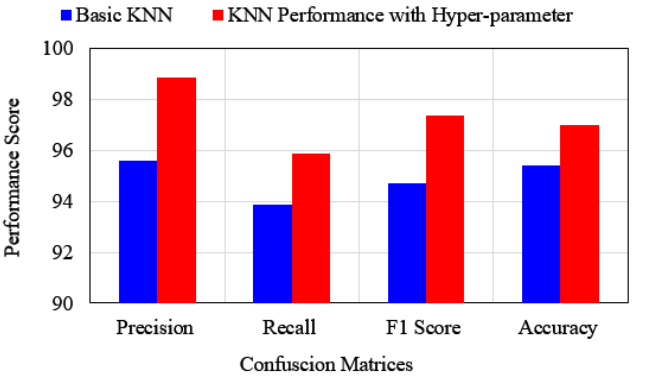
Figure 7. Comparison of KNN performance with basic KNN and KNN with hyperparameter.